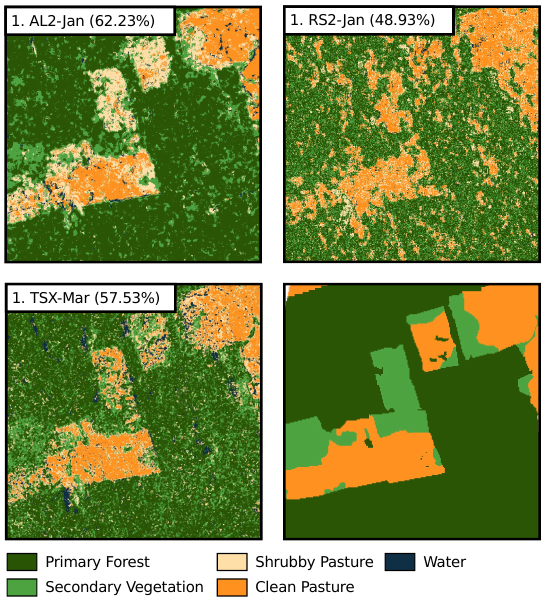
Figure 3. Comparison of the single scene mapping capabilities. Scenes are shown that yield the highest overall accuracy per sensor. The bottom right shows the TerraClass reference image.